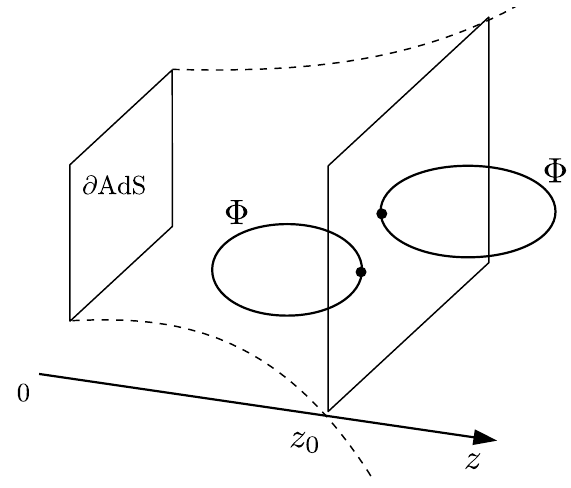
Figure 3 . A brane (i.e. an interface or domain wall) along the z = z 0 slice in the Poincaré patch of AdS . Loops of the scalar field Φ in each region induce a finite pressure on the d +1